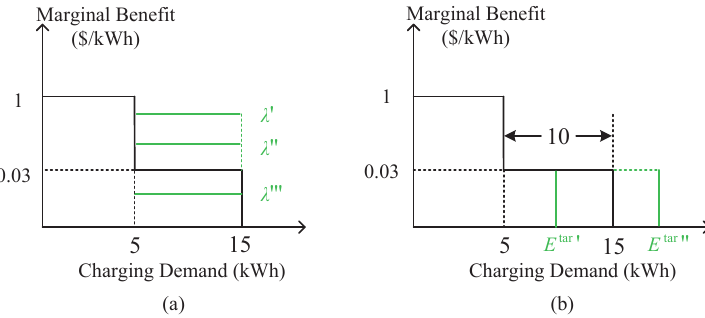
Figure 12. Demand curves with different marginal benefits and quantity demanded. ( a ) different marginal benefits; ( b ) different charging